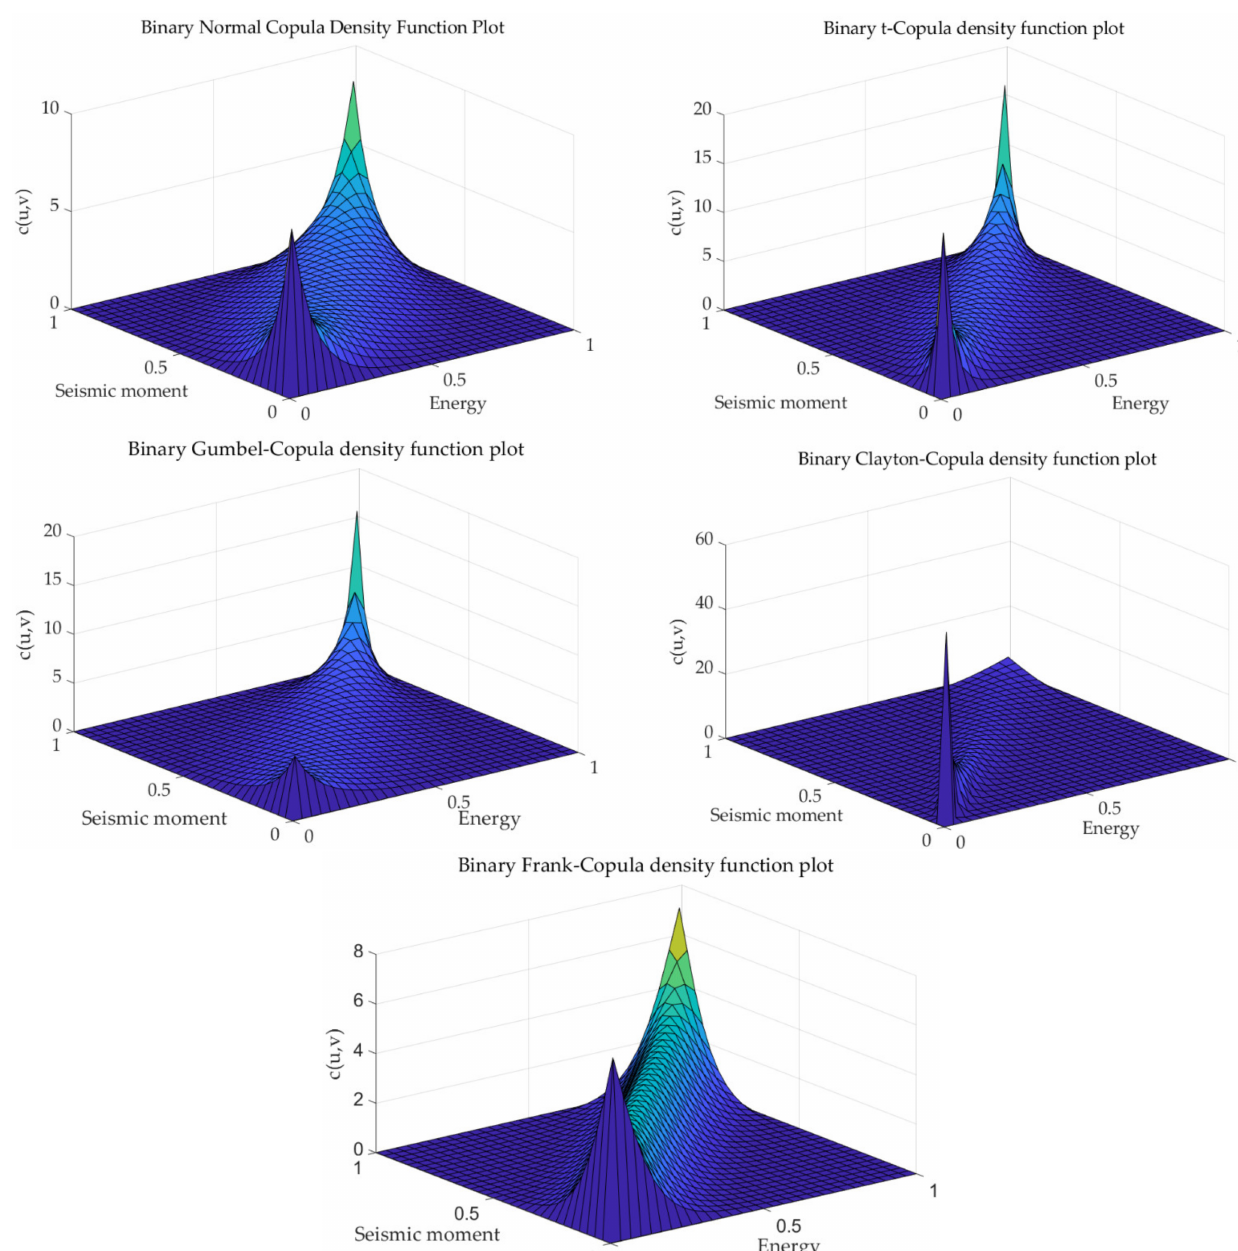
Figure 3. Probability density map of common Copula